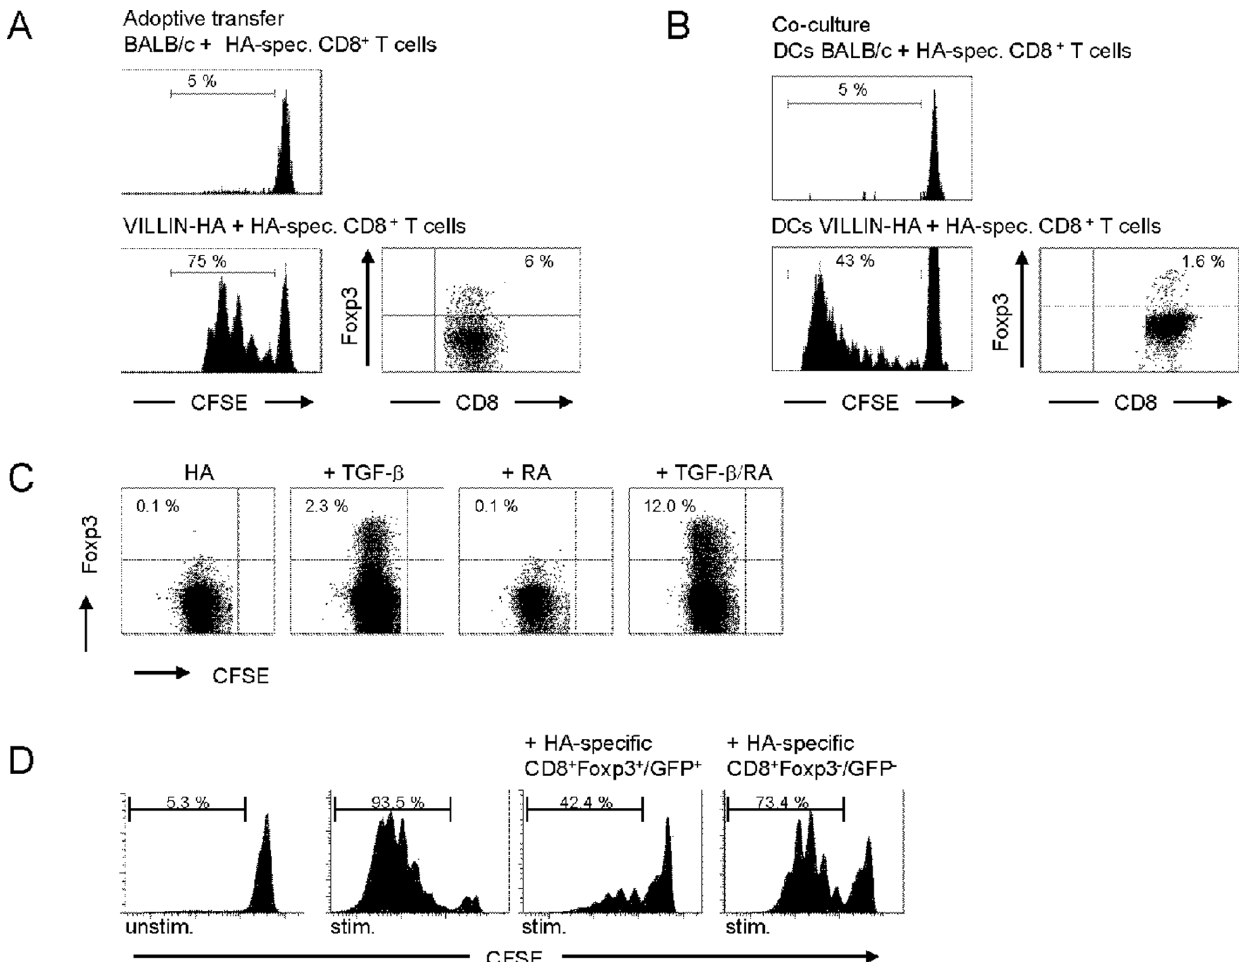
Figure 5. Peripheral induction of CD8 + Foxp3 + T cells in vivo and in vitro. (A) CFSE-labeled HA-specific CD8 + CD25 2 T cells from CL4-TCR transgenic mice were adoptively transferred into VILLIN-HA and BALB/c recipient mice. At day 4 after adoptive transfer cells from the MLN of recipient mice were isolated and stained for the expression of CD8 and Foxp3. Histograms show proliferation of HA-specific CD8 + T cells by loss of CFSE dye, dot plot demonstrates the expression of Foxp3 in proliferating CD8 + T cells. (B) DCs from MLN of VILLIN-HA and BALB/c mice were co-cultured with CFSE-labeled HA-specific CD8 + CD25 2 T cells from CL4-TCR transgenic mice for 5 days. Cells were stained for the expression of CD8 and Foxp3. Histograms show proliferation of HA-specific CD8 + T cells by loss of CFSE-dye, dot plot demonstrates the expression of Foxp3 in proliferating CD8 + T cells. (C) CFSE-labeled HA-specific CD8 + CD25 2 T cells from CL4-TCR transgenic mice were co-cultured with MLN DCs from BALB/c mice and exogenous HA peptide for 4 days. Where indicated, cells were supplemented with 2 ng/ml human rTGF- b or 100 nM RA. Cells were stained for the expression of CD8 and Foxp3. Gating on proliferating CD8 + T cells, the expression of Foxp3 vs CFSE fluorescence intensity is demonstrated. Data shown are representative of three independent experiments. (D) For in vitro T cell suppression assays, HA-specific CD8 + T cells were separated into CD8 + Foxp3 2 /GFP - and CD8 + Foxp3 + /GFP + T cells by FACS on CD8 and GFP expression. Sorted T cells were co-cultured with freshly isolated CFSE- labeled HA-specific CD4 + CD25 2 responder T cells and APCs, and stimulated with the cognate HA peptides. Histograms show proliferation of responder T cells as determined by loss of CFSE dye. Data from two independent experiments are shown.